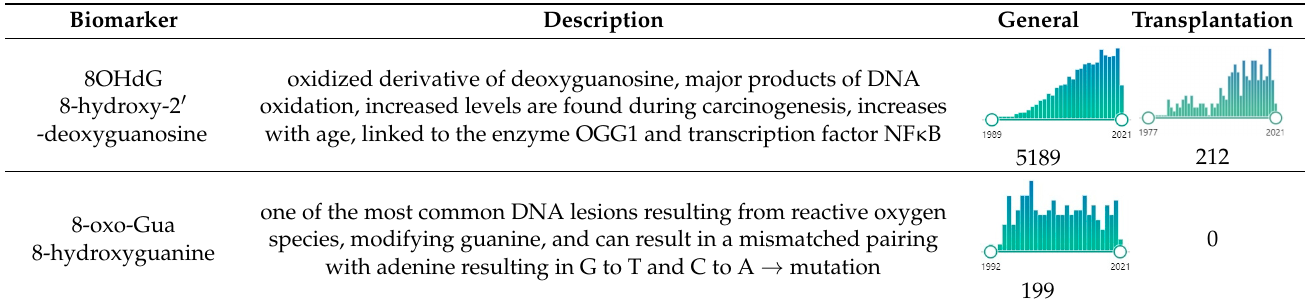
Table 5. Biomarkers of nucleic acids peroxidation—description and research interest.